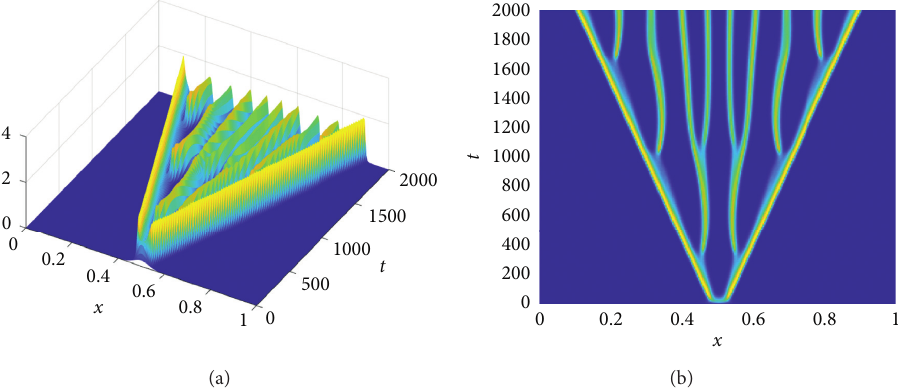
Figure 5: Propagation of the numerical solution of u for the 1D Gray–Scott model by the variable- θ method: (a) the wave-splitting (self- 2 replication of the pulse) and (b) its aerial view over 0 ≤ t ≤ T � 2000, when Δ t � 0 . 01 and Δ x � 0 . 004.